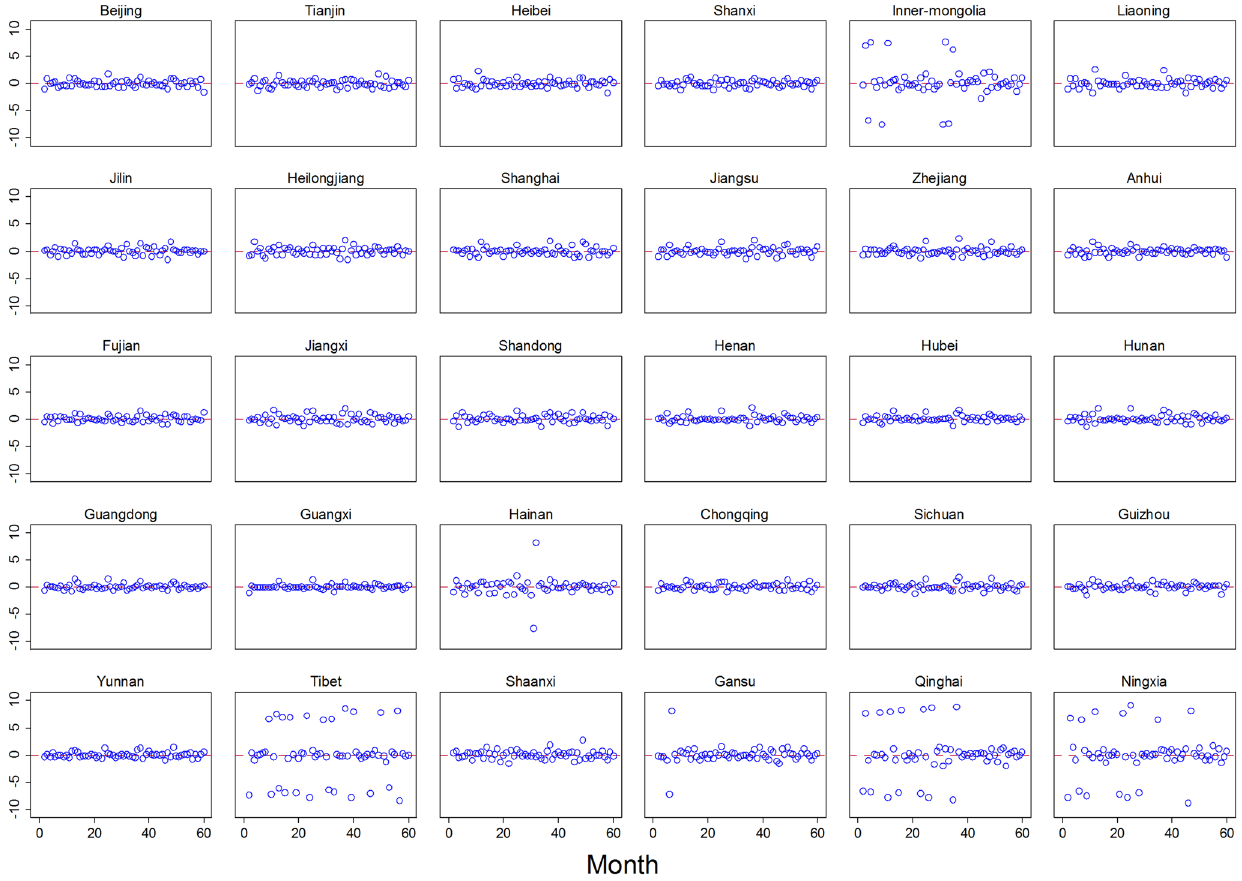
Figure 3. Standard error for the PMG